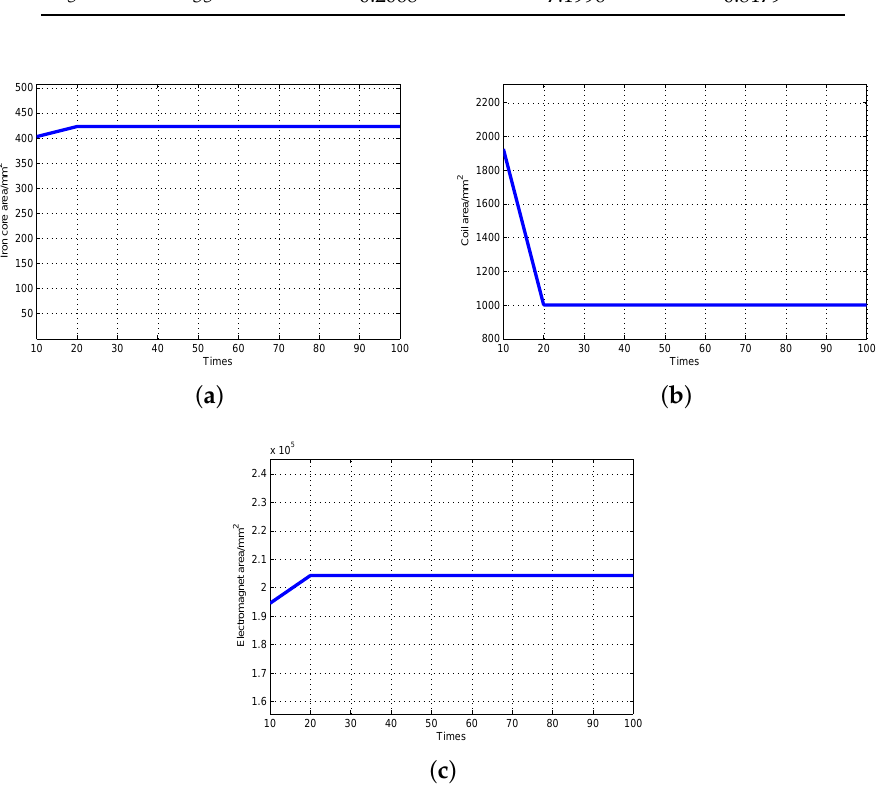
Figure 7. Optimization of electromagnetic structure parameters. ( a ) Optimization of iron core area; ( b ) Optimization of coil area; ( c ) Optimization of electromagnet